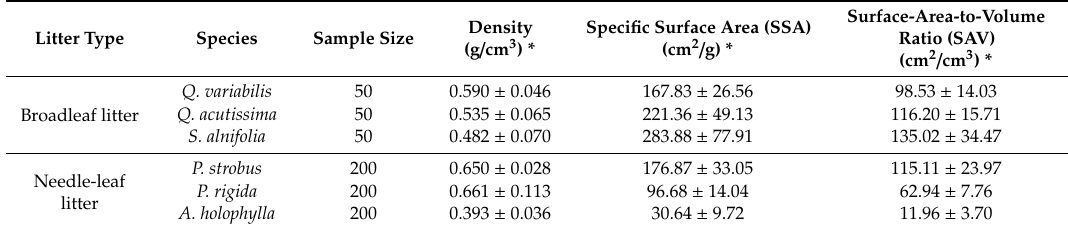
Table 1. Physical characteristics of individual litter